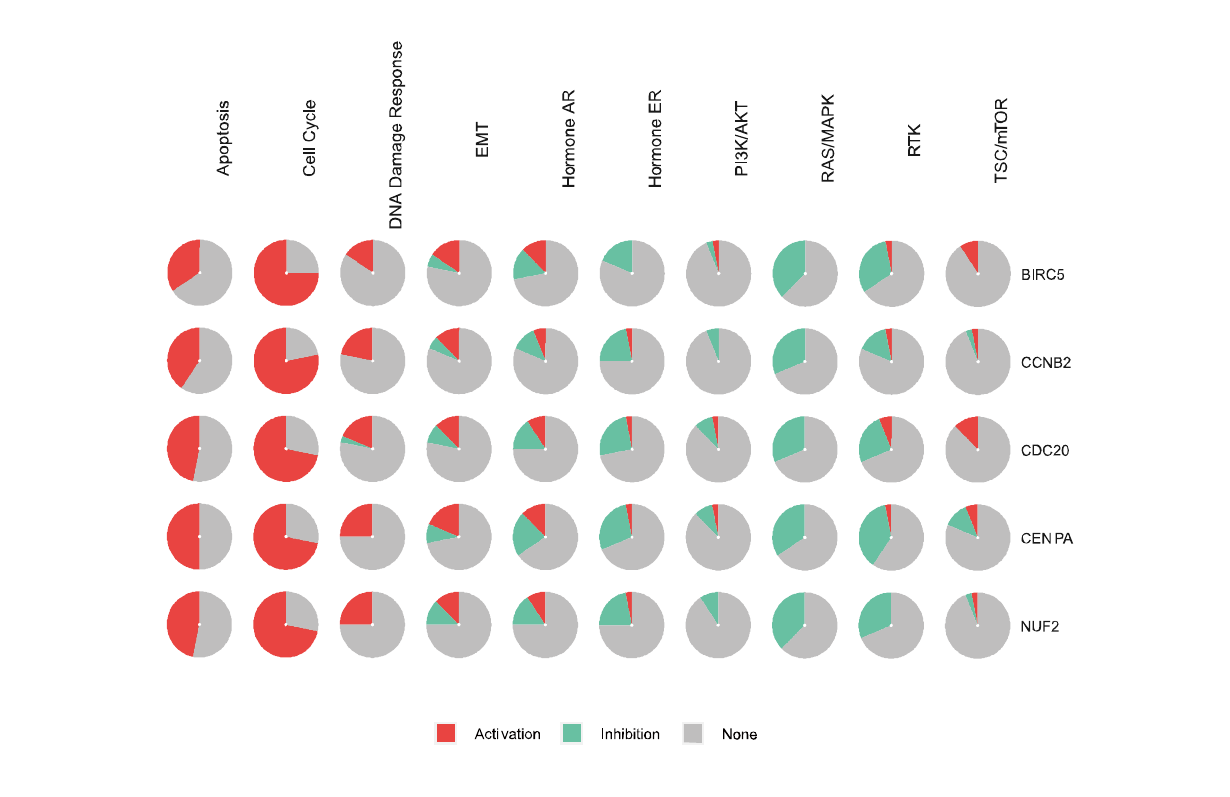
FIGURE 11 | The role of BIRC5 and top four genes in the cancer-related pathways (GSCALite).